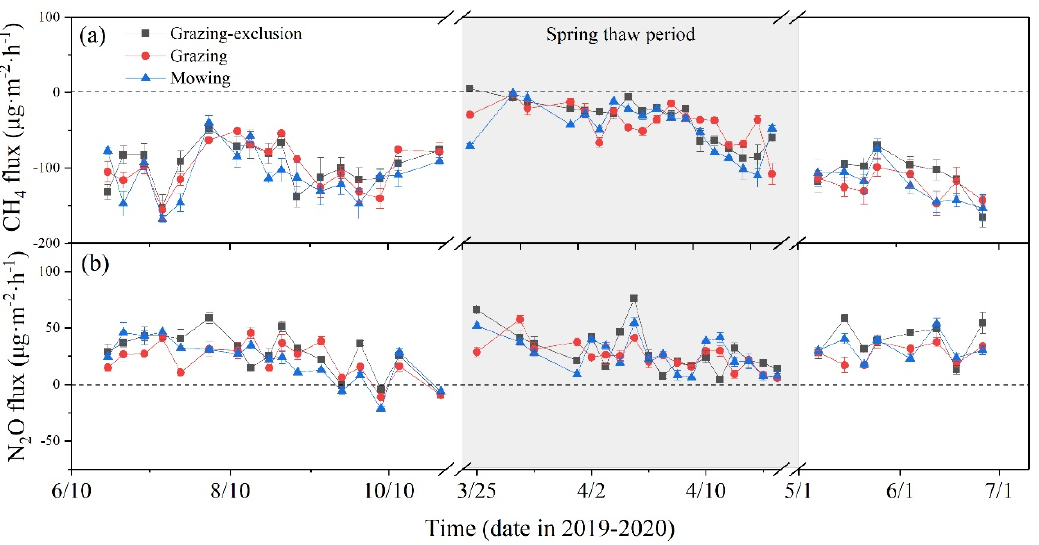
Figure 4. Seasonal variations of CH 4 ( a ) and N 2 O ( b ) fluxes under different land-use types during the period June 2019 to June 2020. Values are mean +SE (standard error) (n = 3). The estimated soil N 2 O fluxes averaged 29.17 μ g m − 2 h − 1 at the GE site, 23.73 μ g m − 2 h − 1 at the G site and 22.67 μ g m − 2 h − 1 at the M site. Nevertheless, there was a nonsignificant